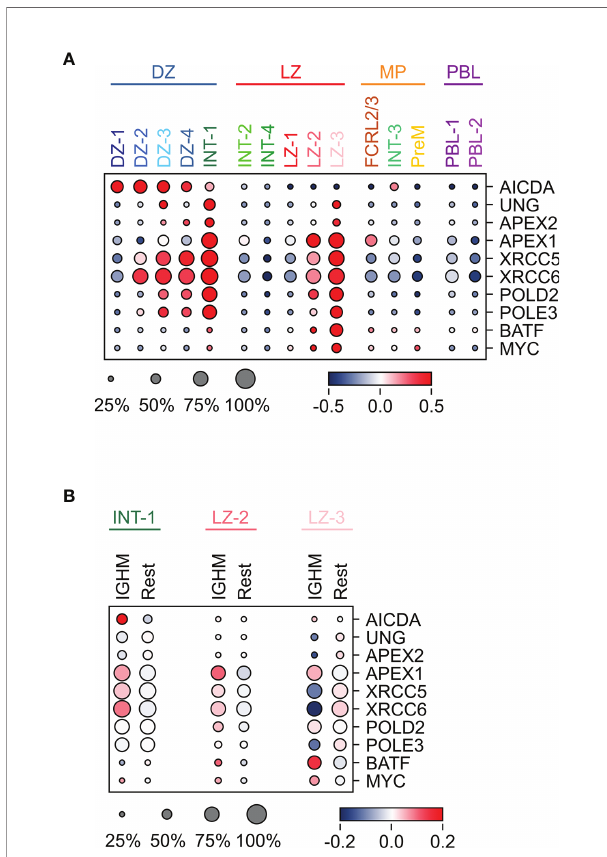
FIGURE 5 | Expression pattern of genes implicated in SHM and/or CSR in GC B cell populations. (A) Heat map displaying the expression of genes implicated in SHM and CSR across the GC populations, identi fi ed by sc- transcriptomics. (B) Heat map displaying the expression of the same genes analyzed in (A) , in unswitched (IGHM) and switched (Rest) cells in the INT-1, LZ-2 and LZ-3 GC clusters. The size of the dot indicates the percentage of cells with detectable expression, and the color re fl ects the relative gene expression shown as the z-scored average (log2) normalized expression within a